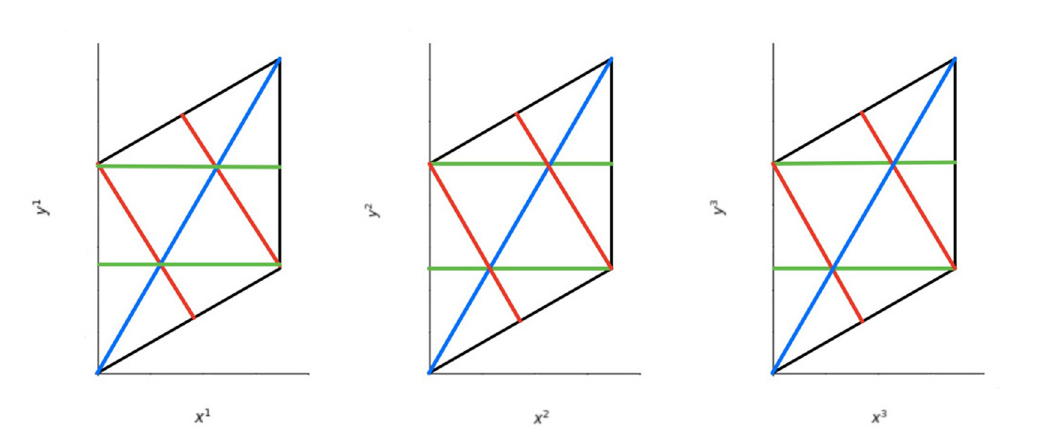
Figure 5. Fundamental domain of T 2 × T 2 × T 2 and the fixed loci for T 6 / Z 3 × Z 3 . Planes Π 0 , Π , Π are represented by the colours green, red and blue 1 2